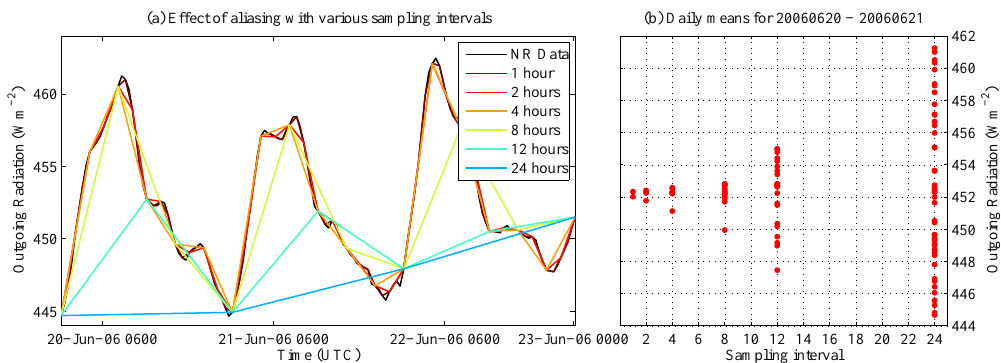
Figure 5. ( a ) Nature Run time series of total outgoing radiation for a three-day period in June 2006. Colored curves show single realizations from the various sampling intervals for the same period; ( b ) The daily means for just 20 June 2006 for all of the realizations from the various sampling